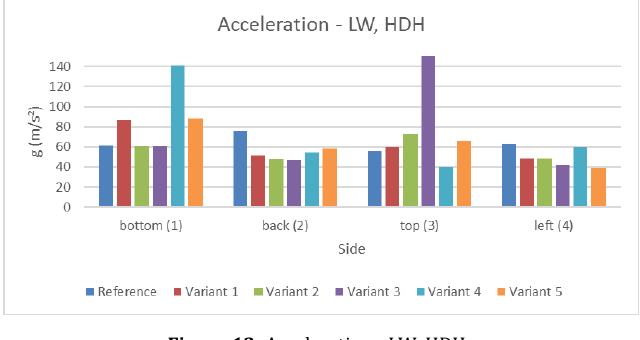
Figure 13: Acceleration - LW, HDH